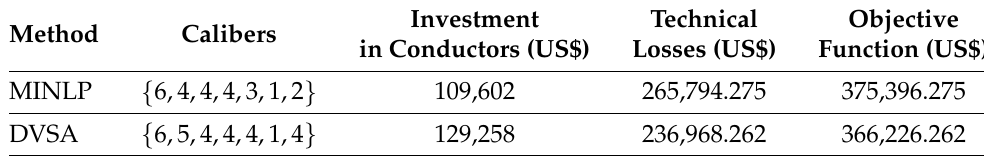
Table 22. Comparative results in the 8-bus systems for the balanced load case for S 3.